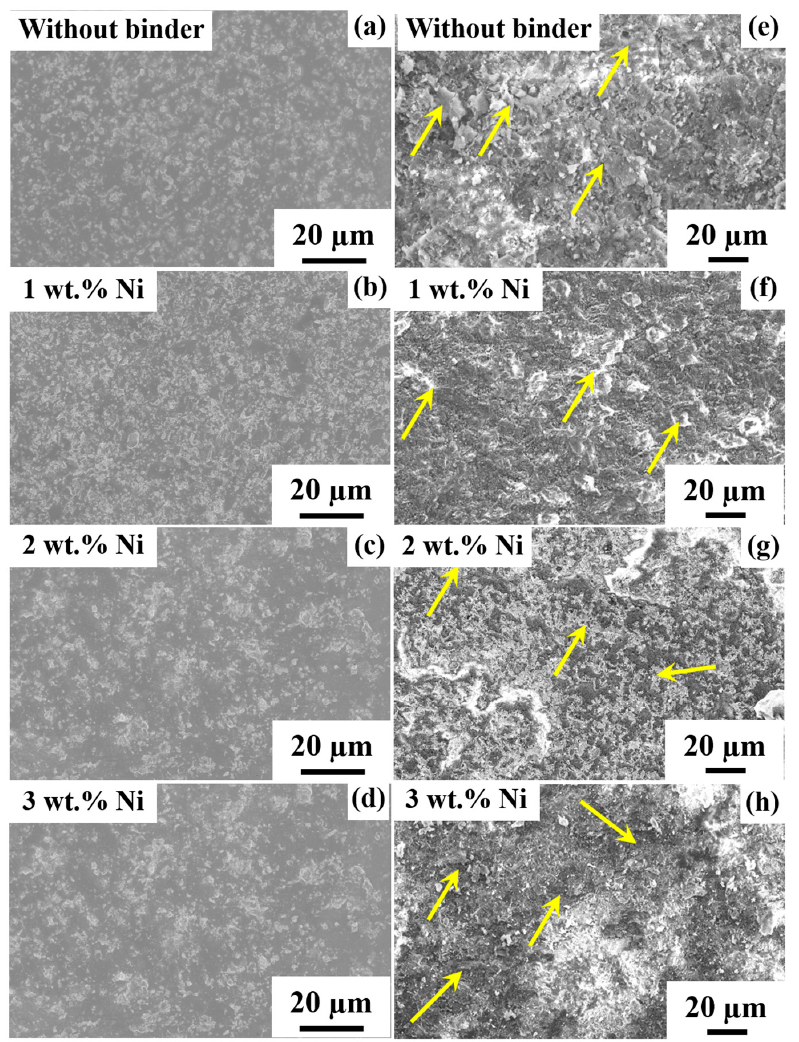
Figure 7. FESEM micrographs of the Al 2 O 3 -10TiC composite samples without Ni and with different contents of Ni ( a – d ) before and ( e – h ) after abrasion test.